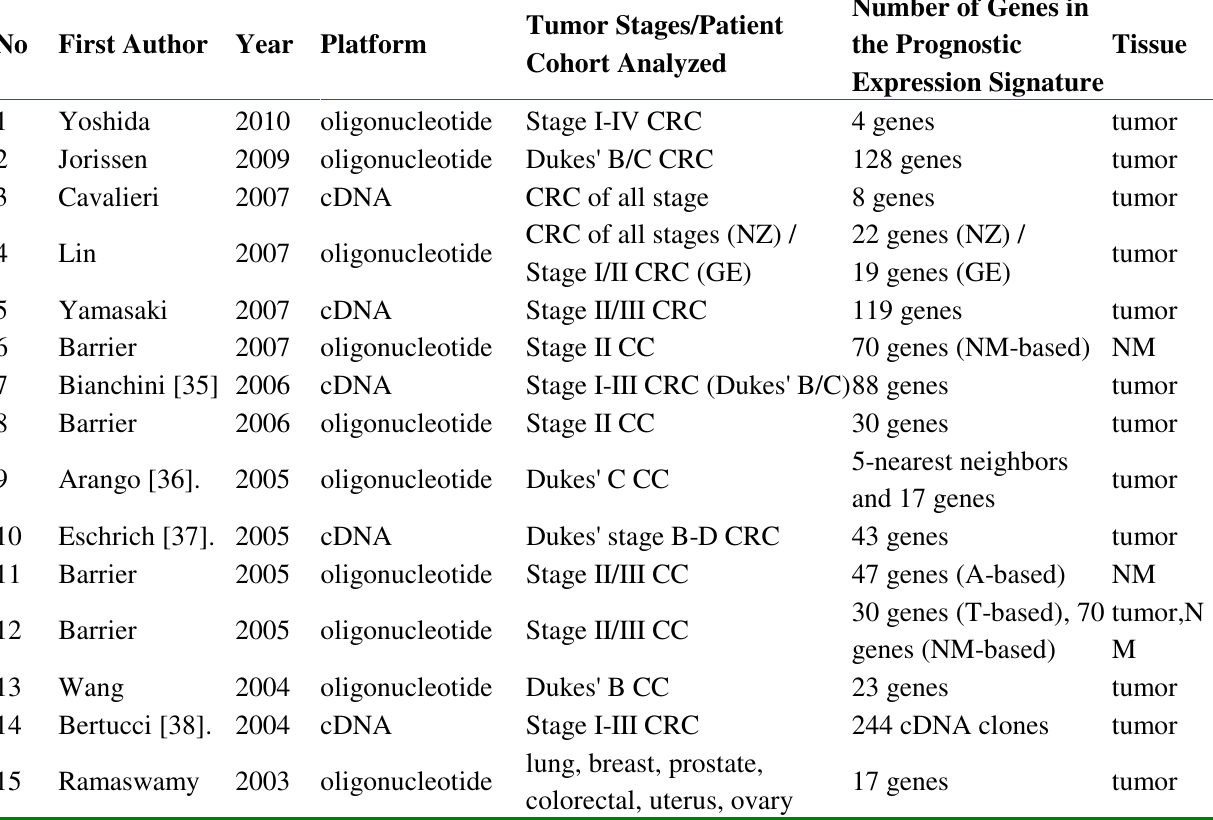
Table 2. Literature on microarrays - sorted by approach, number of cases, and tissue type